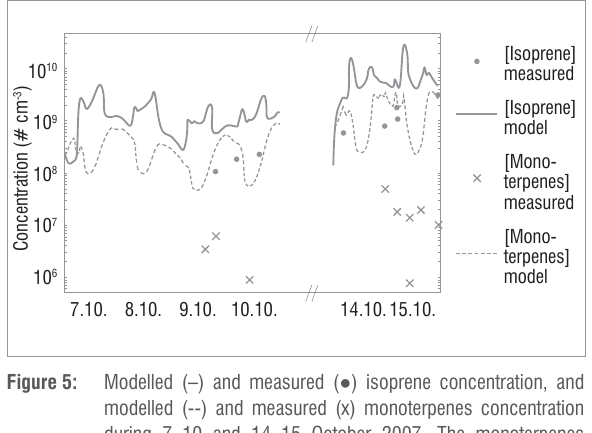
Figure 5: Modelled (–) and measured ( ● ) isoprene concentration, and modelled (--) and measured (x) monoterpenes concentration during 7–10 and 14–15 October 2007. The monoterpenes concentration is the sum of a -pinene, camphene, sabinene, b -pinene, carene, limonene, myrcene and ocimene concentrations, both for modelled and measured values. Measured values are shown at the middle of the 2-h sampling period and are from a height of 5.7 m and the simulated values are from a model height of 5.8 m.